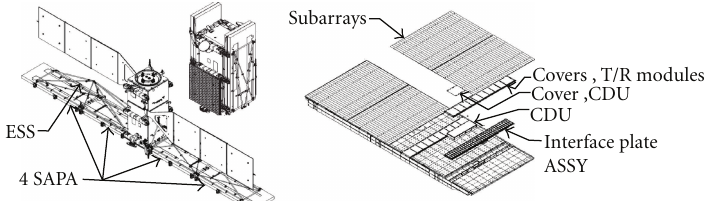
Figure 14: Radarsat 2 antenna, panel and ESS, from [6].